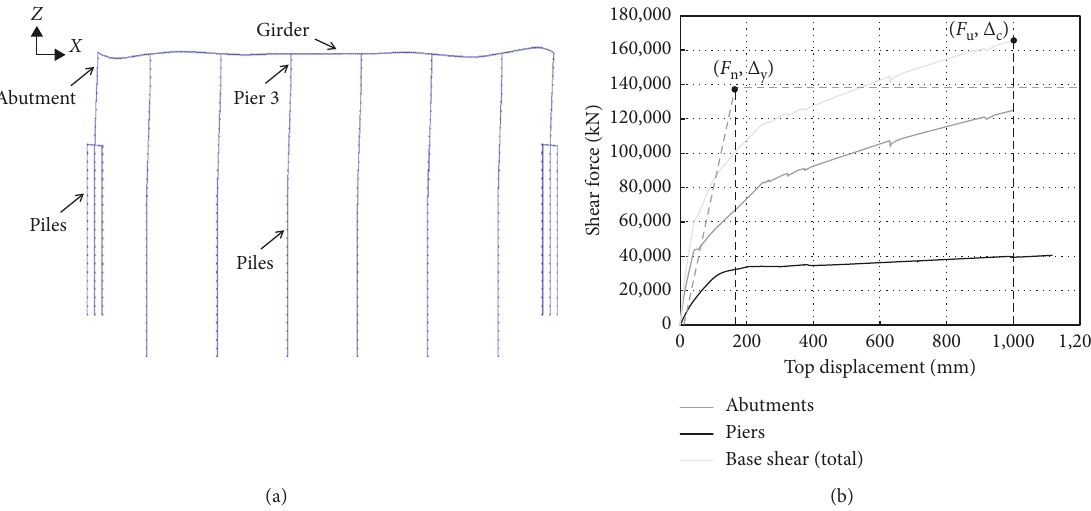
Figure 9: Longitudinal pushover response of the fully integral bridge prototype. (a) Deformed shape. (b) Force-deflection